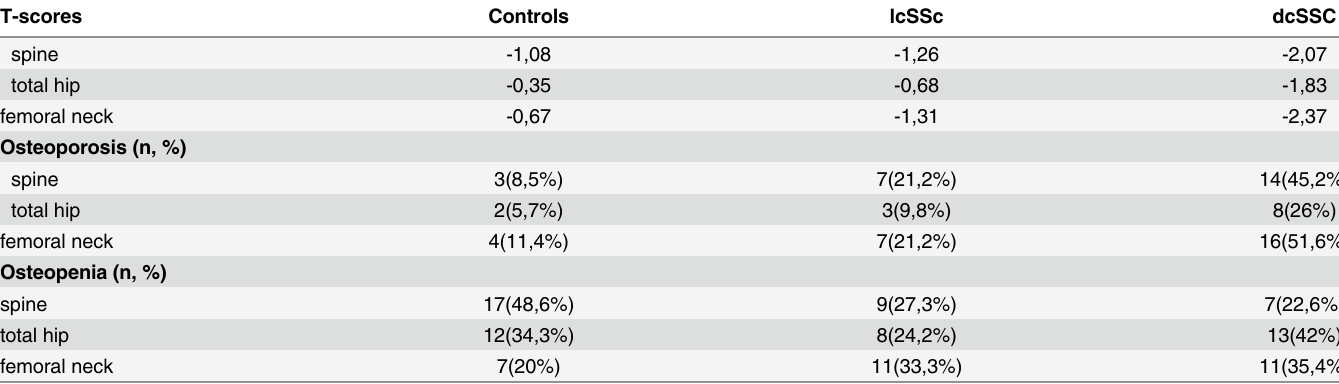
Table 2. T-scores values and prevalence of osteoporosis and osteopenia in healthy controls and SSc patients. T-scores Controls lcSSc